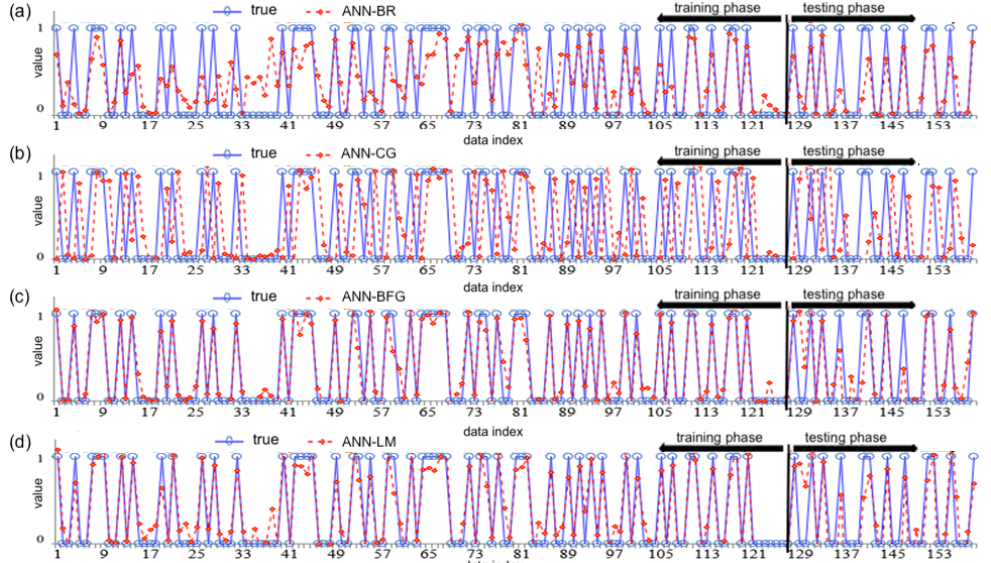
Figure 16. The true data—blue—points versus the predicted (red) data points using ANN–BR ( a ), ANN–CG ( b ), ANN–BFG ( c ) and ANN–LM ( d ) for the training and testing phases; see abbreviations in